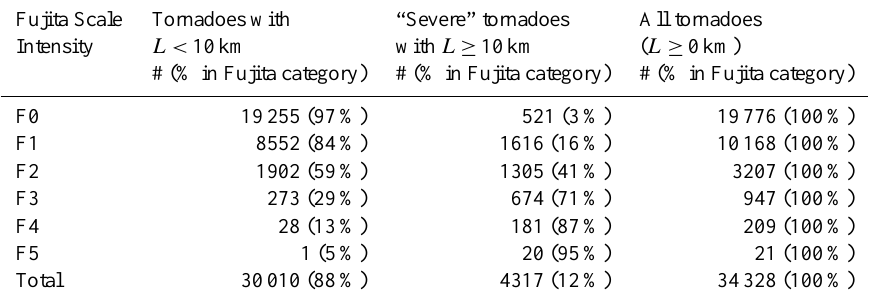
Table 2. Number and percentage of continental USA tornado path lengths from 1982–2011, L< 10km and L ≥ 10km (i.e., “severe” torna- does as defined in this paper), as a function of Fujita scale intensities F. Data are from NOAA